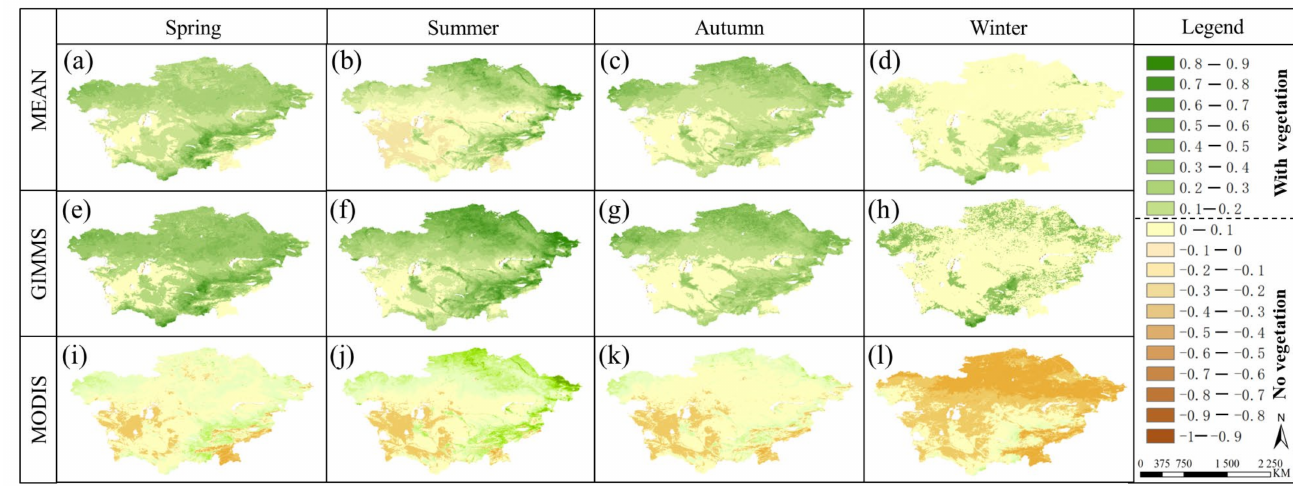
Figure 2. Spatial distribution patterns of GIMMS NDVI ( e – h ), MODIS NDVI ( i – l ), and their mean values ( a – d ) in different seasons.